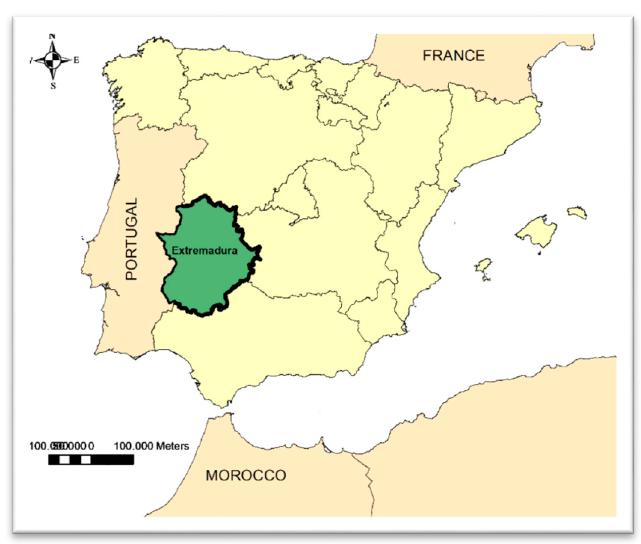
Figure 1. Location of area of study. Table 1. Tourism Magnitude of Extremadura (year 2019).